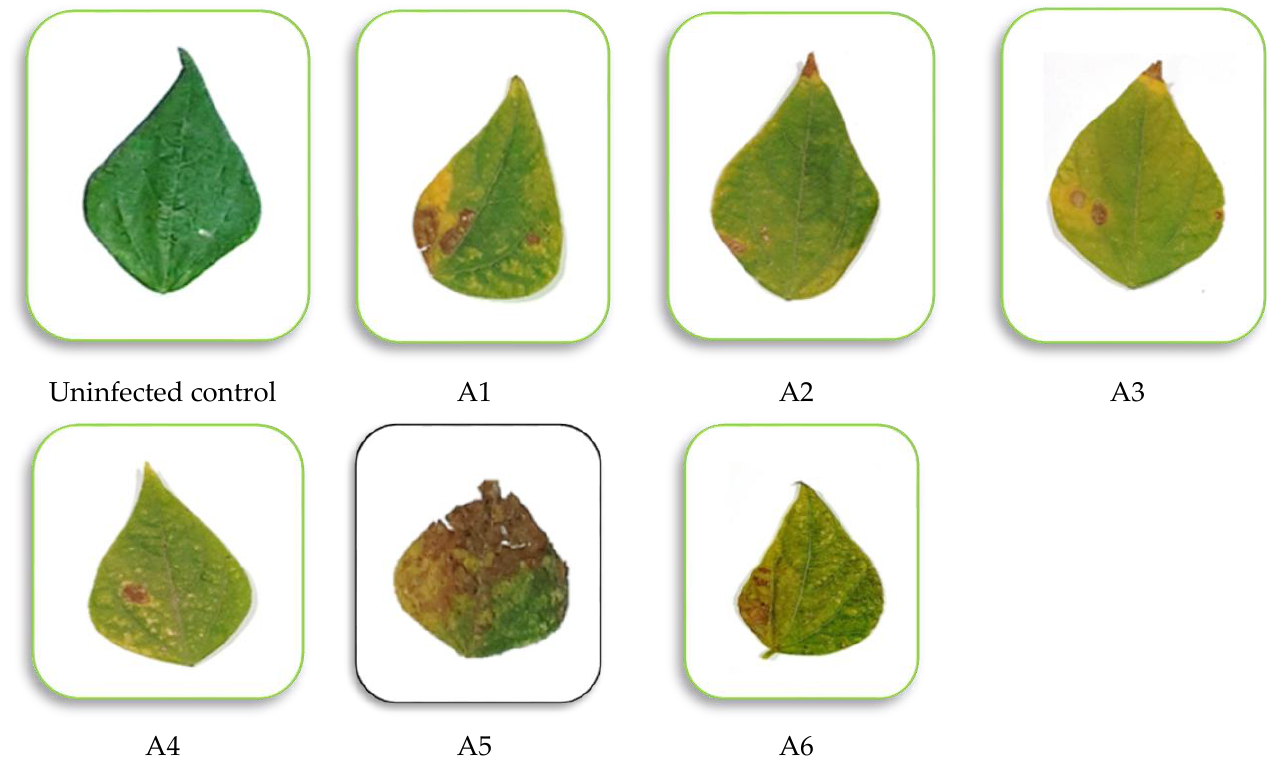
Figure 2. Images illustrating how the six isolates of Alternaria alternata affected the common bean plants. The images were taken 21 days after inoculation under greenhouse conditions.